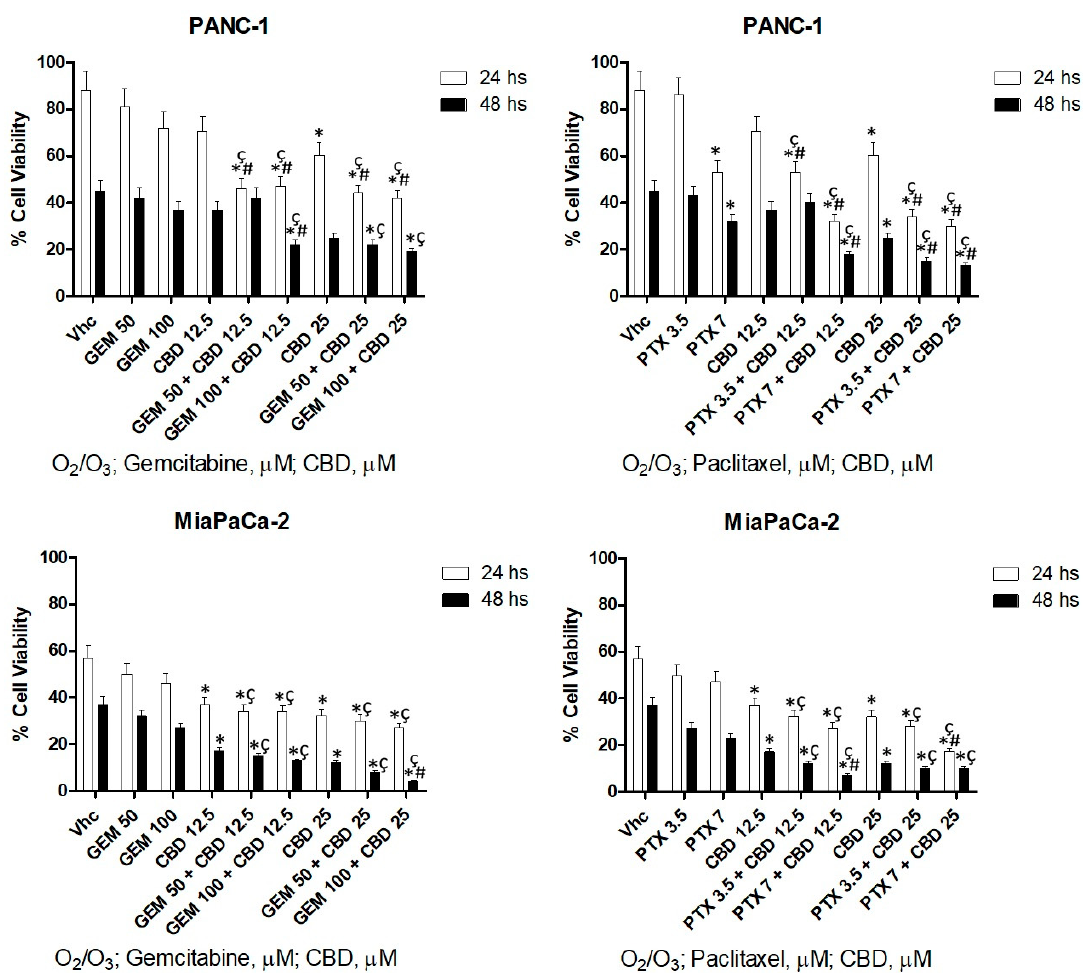
Figure 9. Addition of O 2 /O 3 improves cytotoxic effect of CBD and chemotherapeutic drugs. Cell viability was determined in PDAC cell lines by MTT assay, and the percentage of cell viability was calculated compared with O 2 /O 3 alone. Vhc showed in the graph is O 2 /O 3 alone. O 2 /O 3 conditioned cells were treated for 24 and 48 h with CBD, alone and in combination with different doses of GEM and PTX. Data shown are expressed as mean ± SE of three separate experiments. * p < 0.05 vs. Vhc # p < 0.05 vs. CBD alone, ç p < 0.05 vs. chemotherapeutic drug alone.